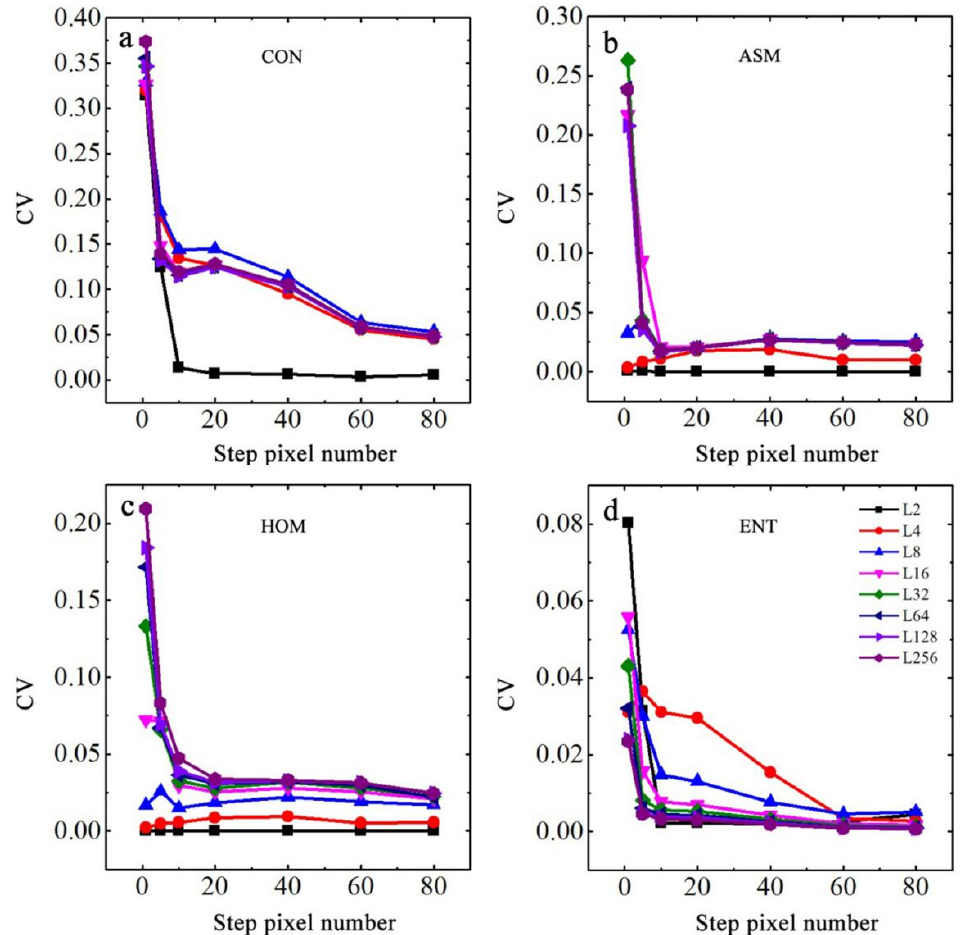
Figure 6. Coefficients of variation of four texture features in four directions of a typical soil sample. ( a ) for texture feature of CON; ( b ) for texture feature of ASM; ( c ) for texture feature of HOM; ( d ) for texture feature of ENT.